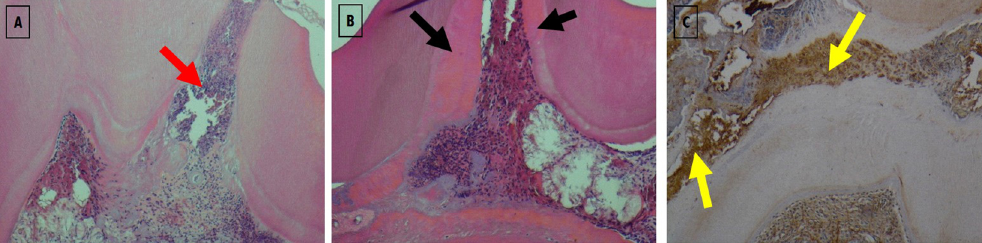
Figure 11- Images of histological sections of groups 2, 3 and 4 at 21 days of follow - up stained with H&E and by immunohistochemistry for DSP. The A image corresponding to group 2 (positive control) was stained with H&E and obtained with 100x magnification. Red arrow – intense inflammatory infiltrate with total disorganization of the pulp tissue. Image B corresponding to Group 3 (WhiteProRoot ® MTA therapy) was stained with H&E and obtained with 100x magnification. Black arrows – deposition of mineralized tissue near the exposure zone, immediately adjacent to the dentin tissue, revealing an incomplete dentin bridge. The image C corresponding to Group 4 (Biodentine™ therapy) was stained by immunohistochemistry for the DSP and obtained with 100x magnification. Yellow arrows – intense DSP marking next to the pulp exposure zone